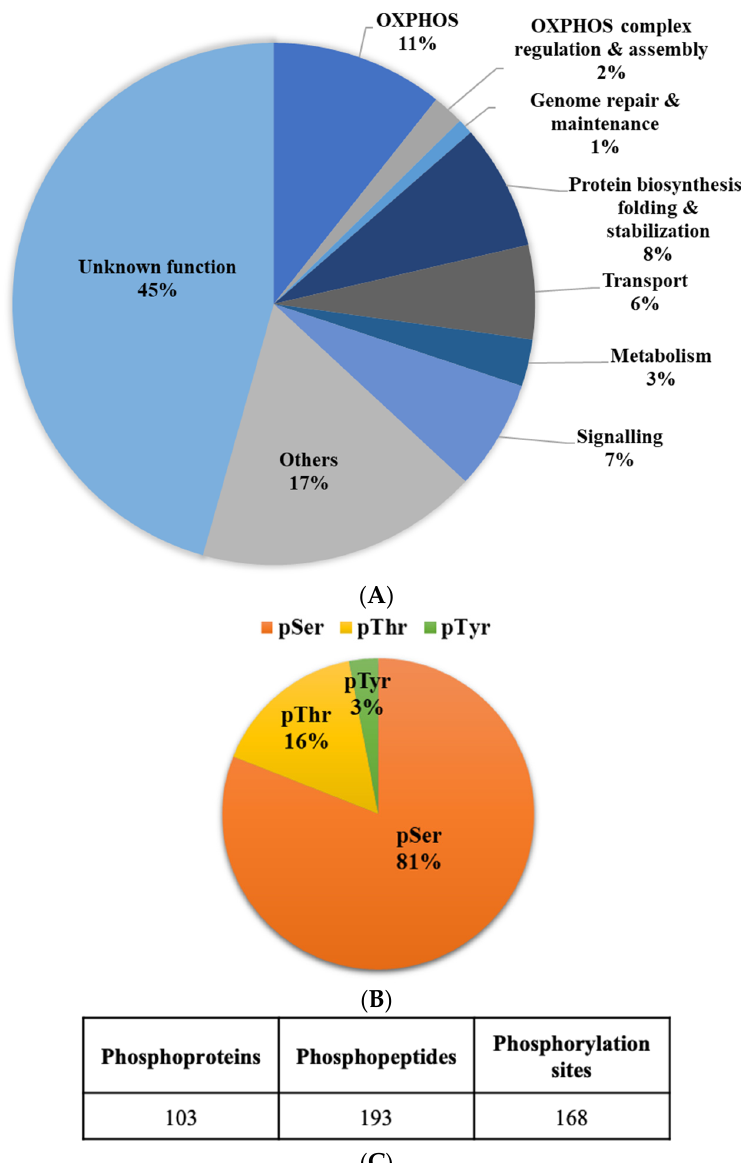
Figure 3. Profiling phosphoproteins of D. discoideum mitochondria. ( A ) Proportion and functional categories of identified phosphoproteins in mitochondrial preparations; ( B ) distribution of serine (pSer), threonine (pThr), and tyrosine (pTyr) phosphorylation sites in identified proteins; ( C ) the number of non-redundant phosphoproteins, phosphopeptides and phosphorylation sites identified in mitochondrial preparations from D. discoideum WT and HPF444 strains.